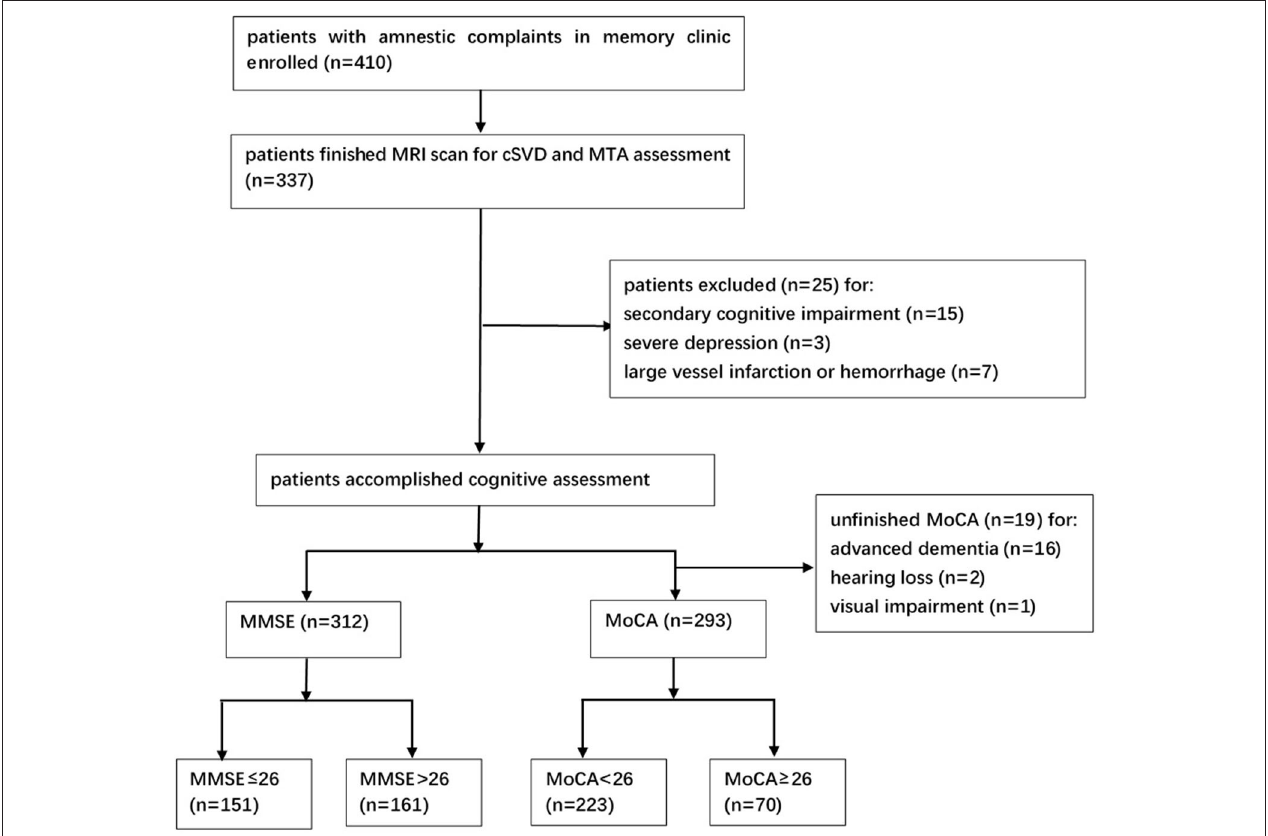
FIGURE 1 | Study flowchart. MRI, magnetic resonance imaging; cSVD, cerebral small vessel disease; MTA, medial temporal atrophy; MMSE, Mini-Mental State Examination; MoCA, Montreal Cognitive